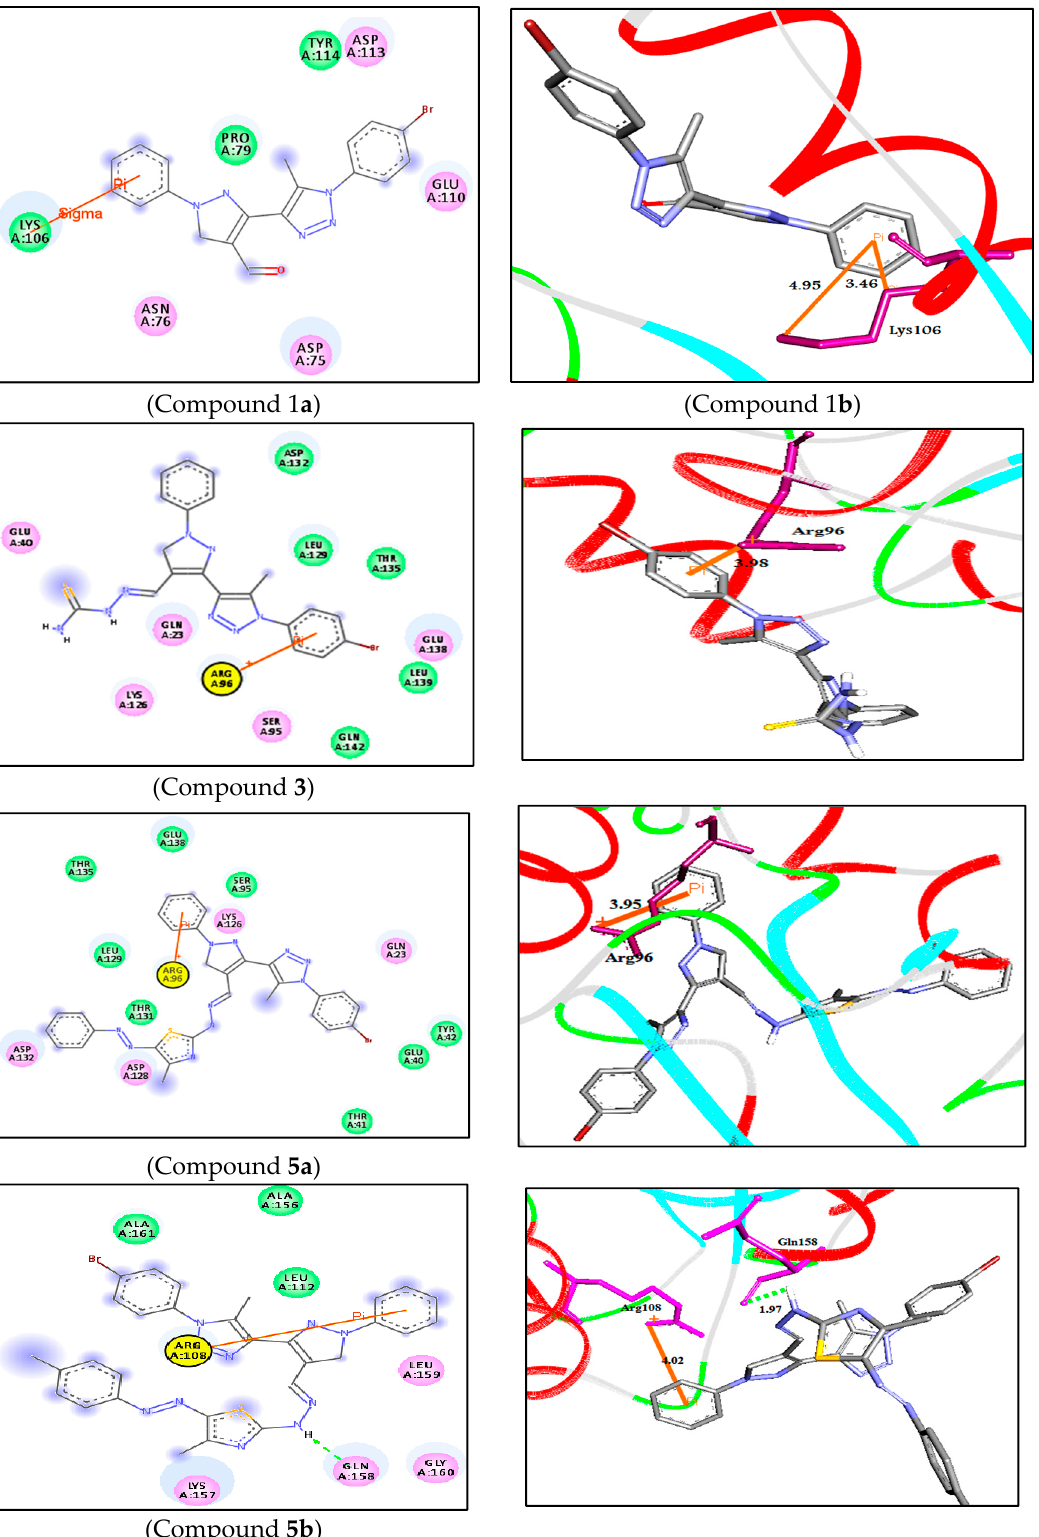
Figure 1. 2D and 3D representations of Rho6-compound complexes. Hydrogen bonds are represented in green and blue dotted lines, while π -stacking are shown in orange lines.